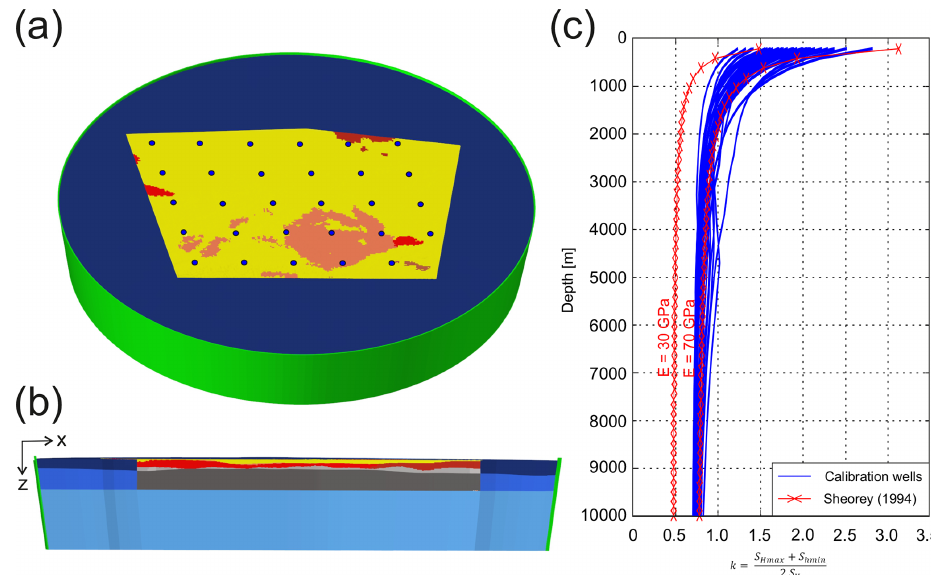
Figure 6. (a) Top view of the model implemented in the shell (green) and the sideburden (dark blue). Blue dots indicate the synthetic calibration wells. (b) Side view of the model implemented in the shell, the sideburden and the underburden (bright blue). (c) k values of the calibration wells (blue curves) in comparison with k values calculated with a semi-empirical function by Sheorey (1994) for a Young’s modulus of 30 and 70GPa representing the sedimentary and the upper crust units (red